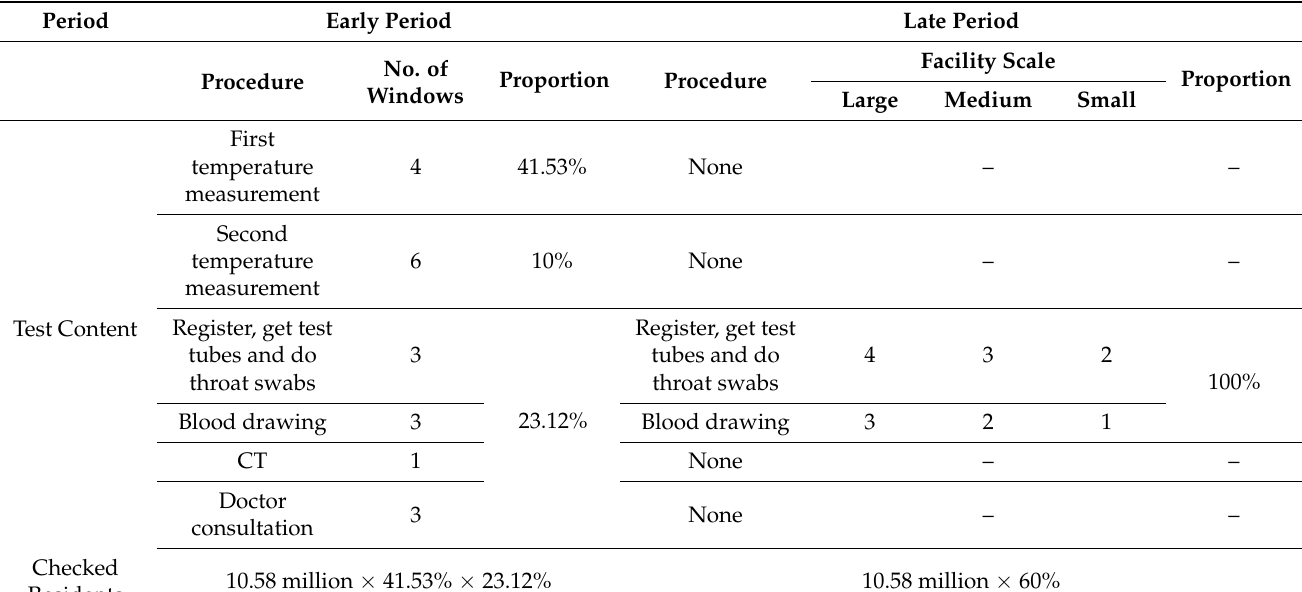
Table 2. Transformation of testing process and simulation setup in community health service centers.